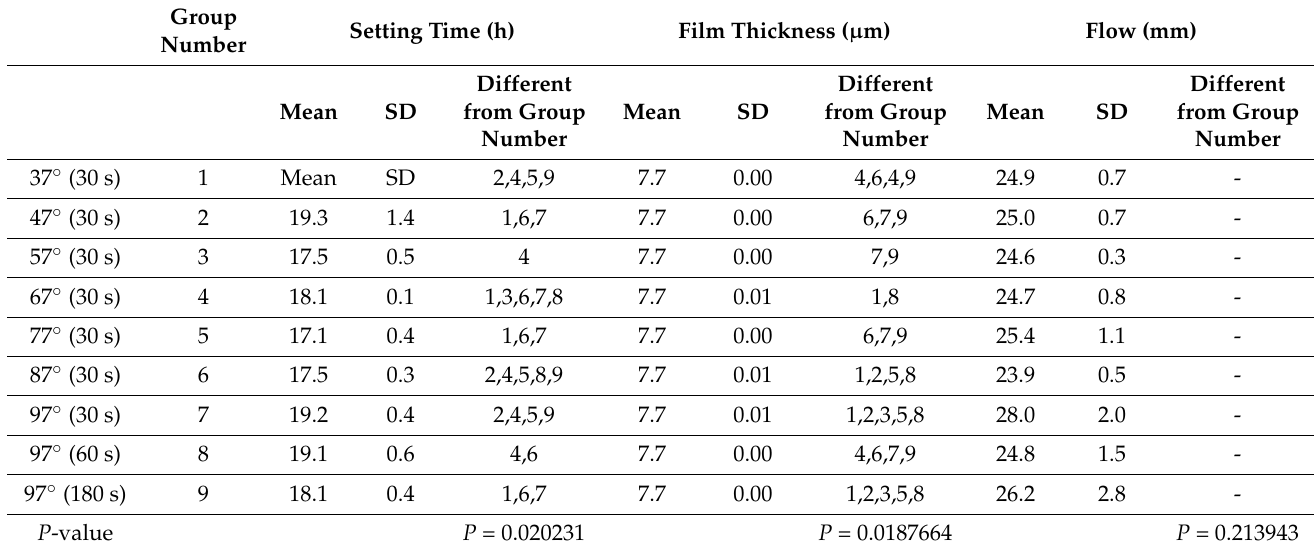
Table 3. Physical properties in accordance with ISO 6876:2012 of Total Fill BC Sealer (means and standard deviations (SD)) after thermal treatment. Statistical analysis of setting time, film thickness and flow for Total Fill BC Sealer was performed by Kruskal-Wallis-Test ( P = 0.05).